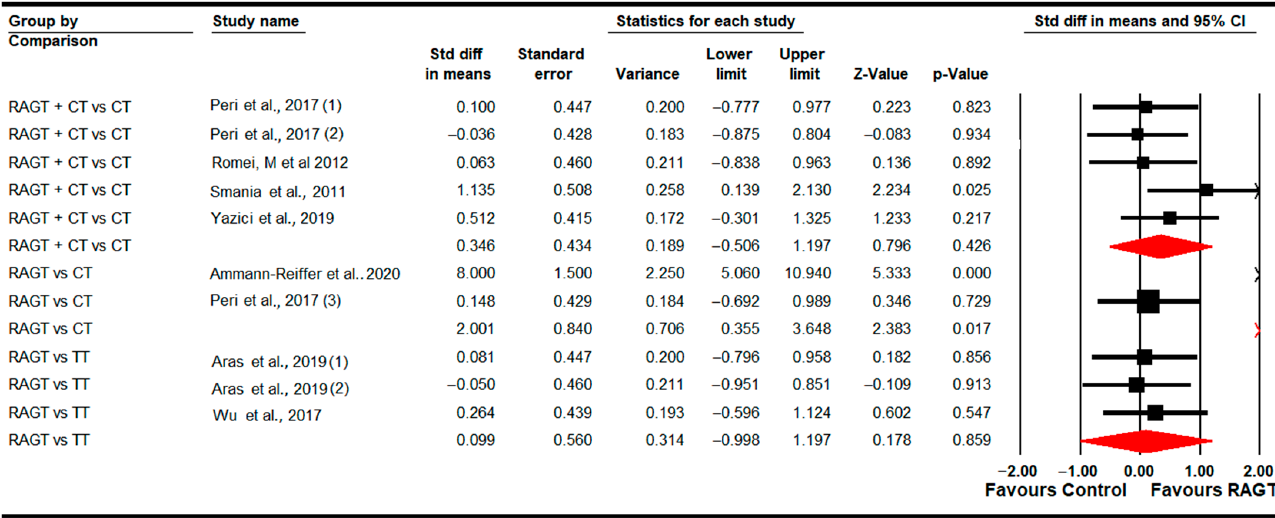
Figure 6. Forest Plot of Walking Distance (Post-Intervention Assessment) [78–80,83,84,89,91]. Subgroup analyses revealed no statistically significant differences between RAGT